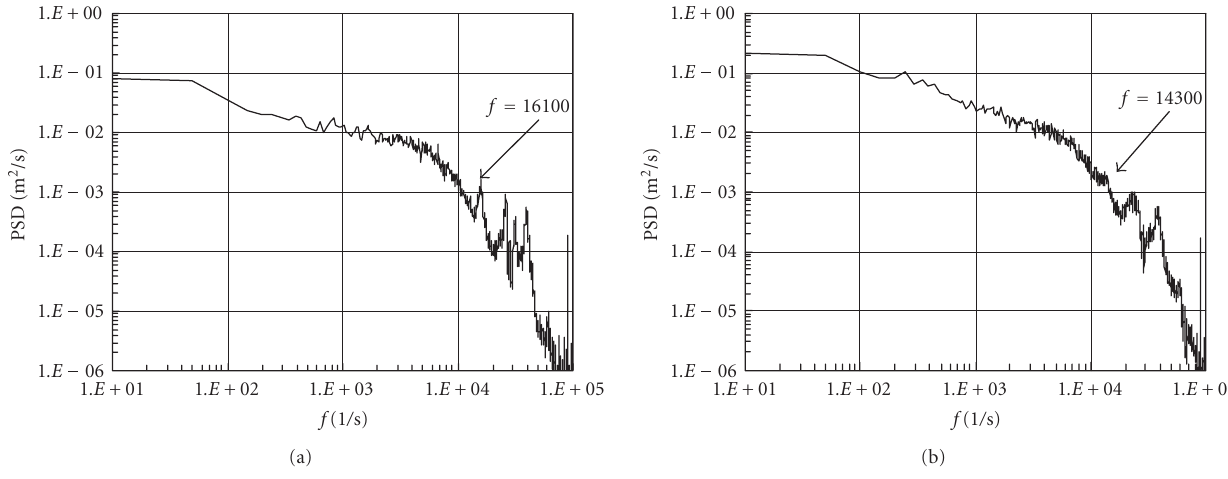
Figure 8: Power spectral density profiles measured in the wake flow one axial chord length downstream of the smooth cambered airfoil for Tu = 0 . 9 percent. (a) Pressure side wake at y/cx = 0 . 10. (b) Suction side wake at y/cx = − 0 .